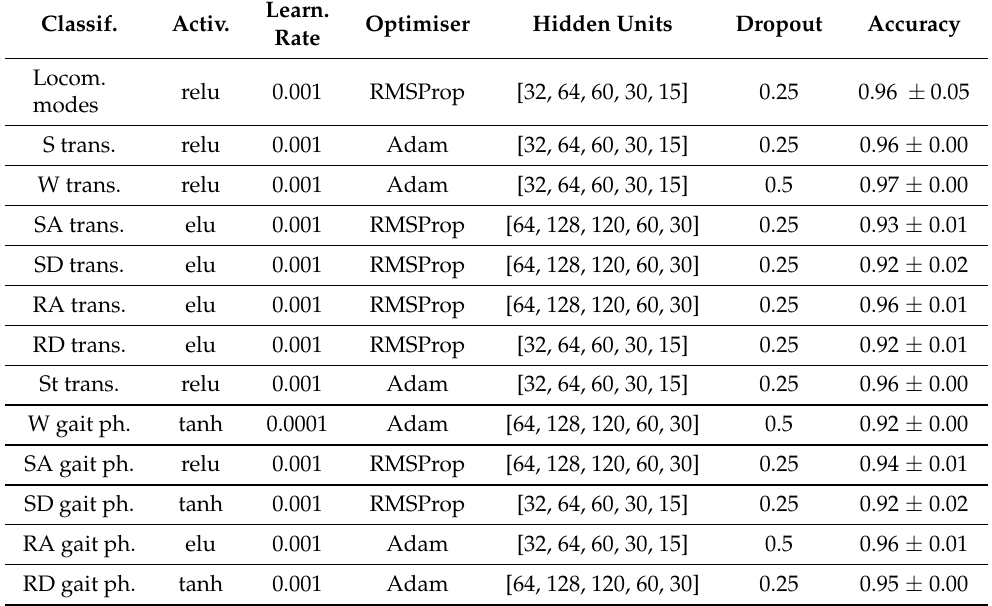
Table 5. Grid search results. Best found hyperparameter value combination for each neural network.